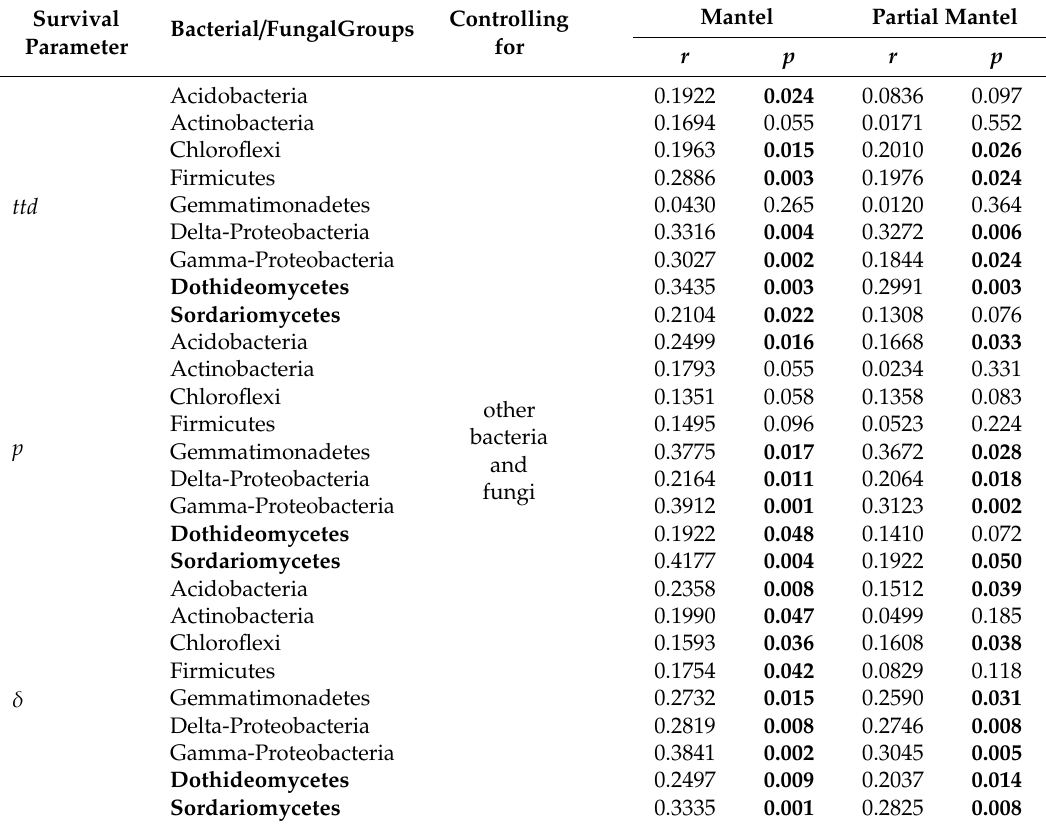
Table 3. Mantel test and partial Mantel test between survival parameters ( ttd , p , and δ ) and dominant fungal and bacterial phyla and classes. Fungal groups were shown in bold, numbers in bold indicate correlation was significant at 0.05